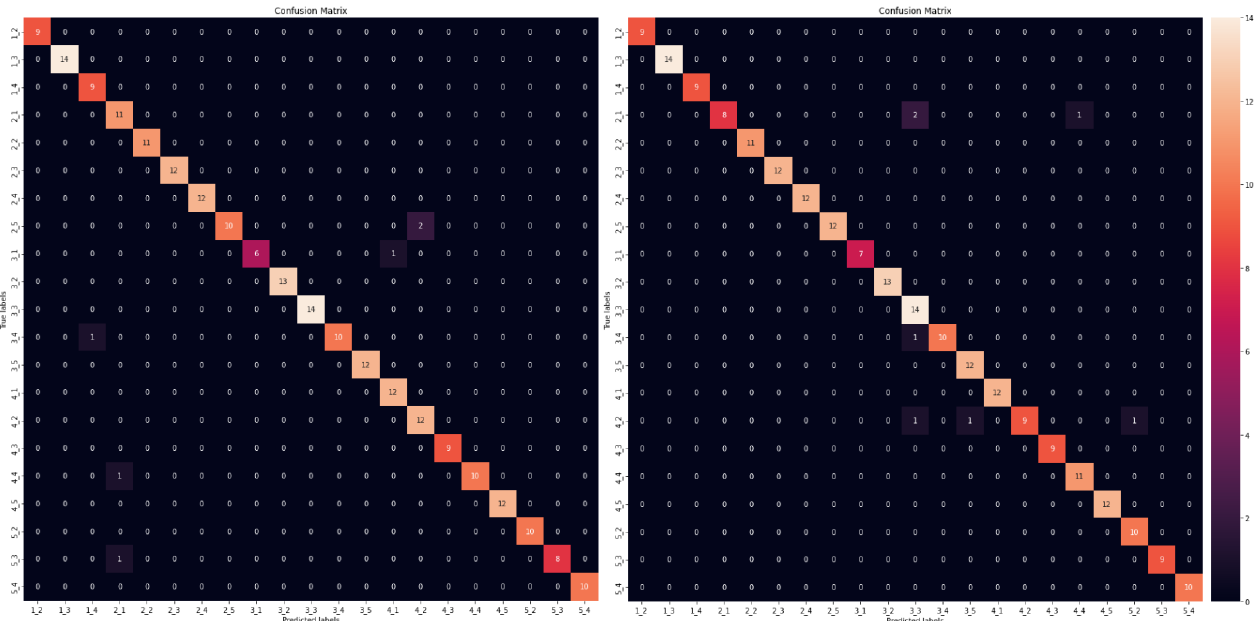
Figure 10. Confusion matrices for random forest ( left ) and shallow neural network ( right